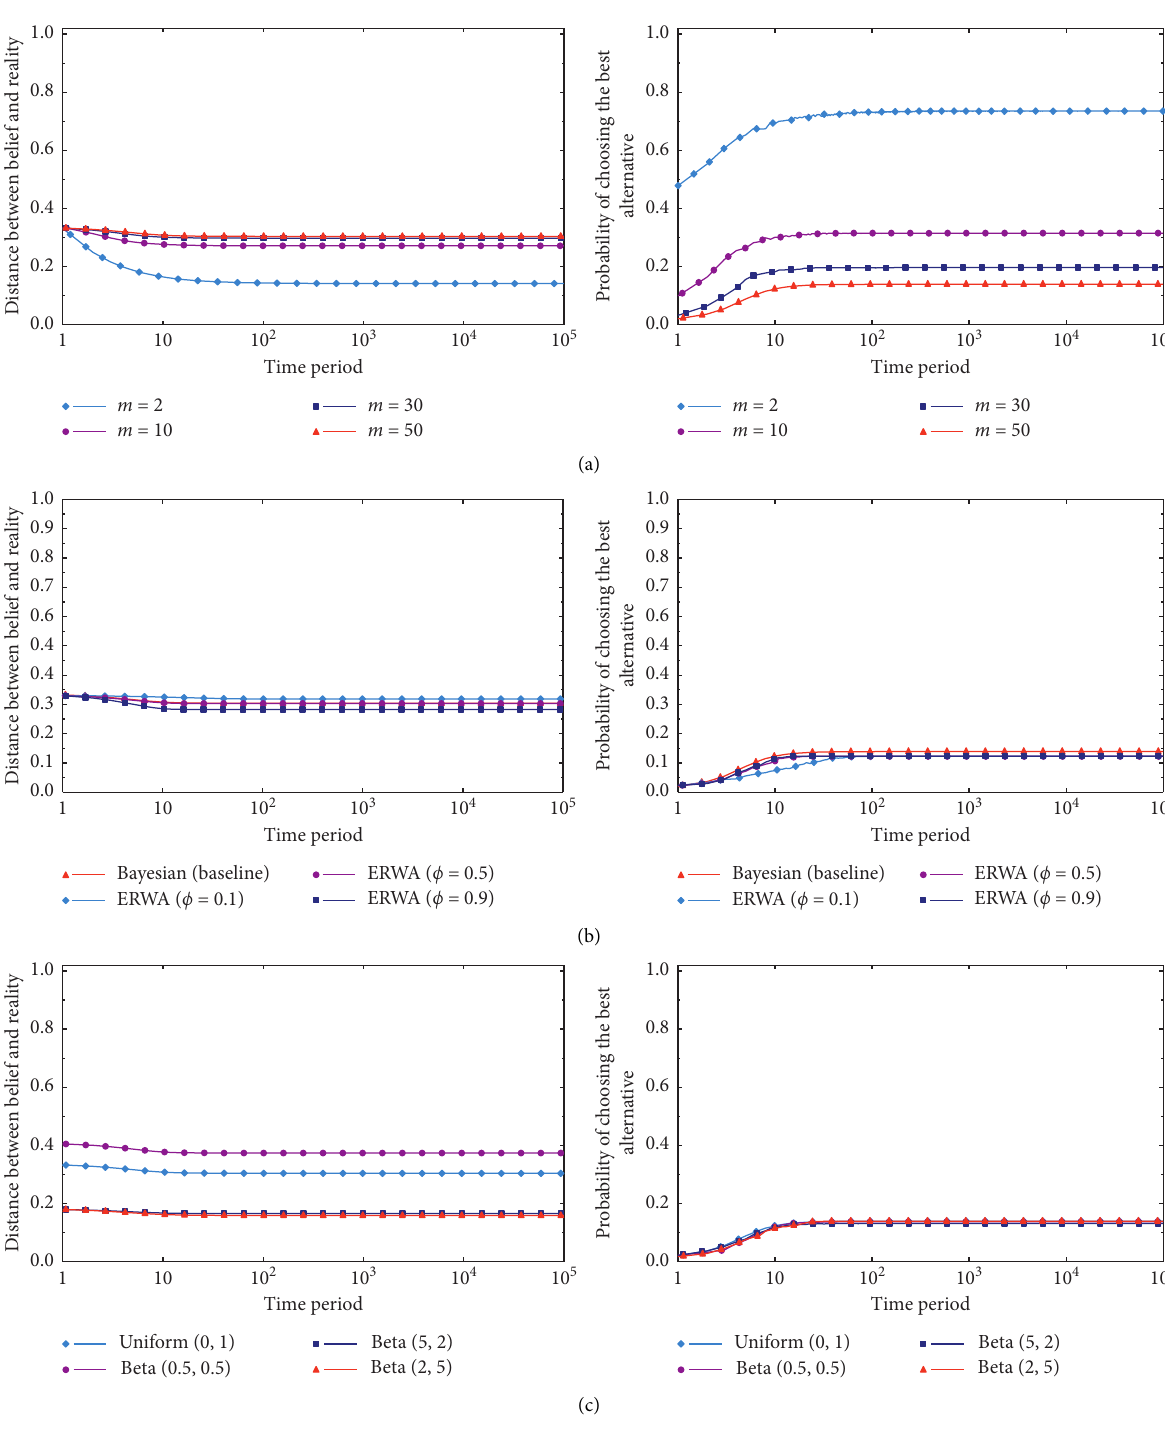
+ ϕ Π i,t ), and (c) distribution of 1